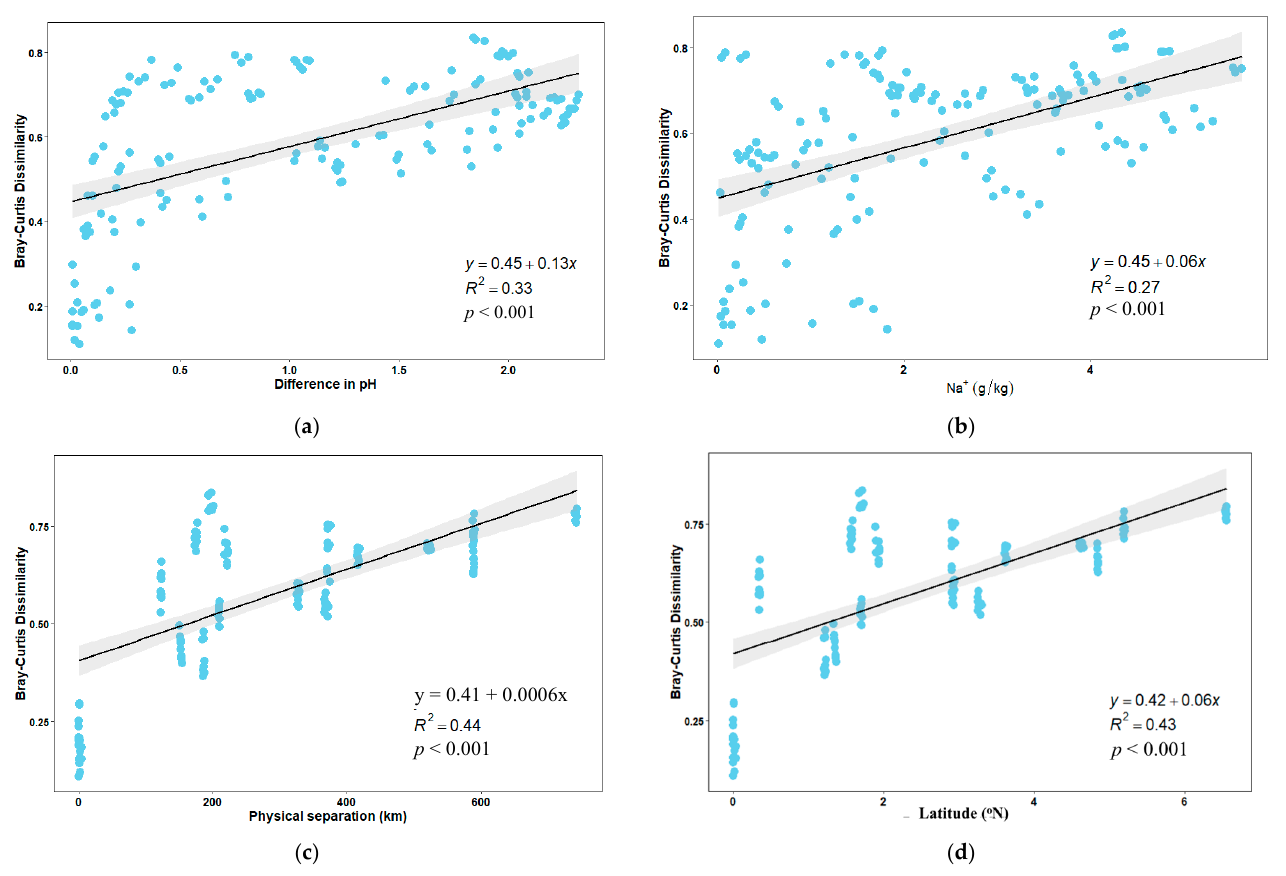
Figure 4. The bacterial beta diversity based on distance-based redundancy analysis (db-RDA) of driving factors of bacterial community composition. The environmental factors are plotted as vec- tors, and the length of the vector represents the magnitude of the impacts. The angles between vec- tors reflect their (linear) correlation.